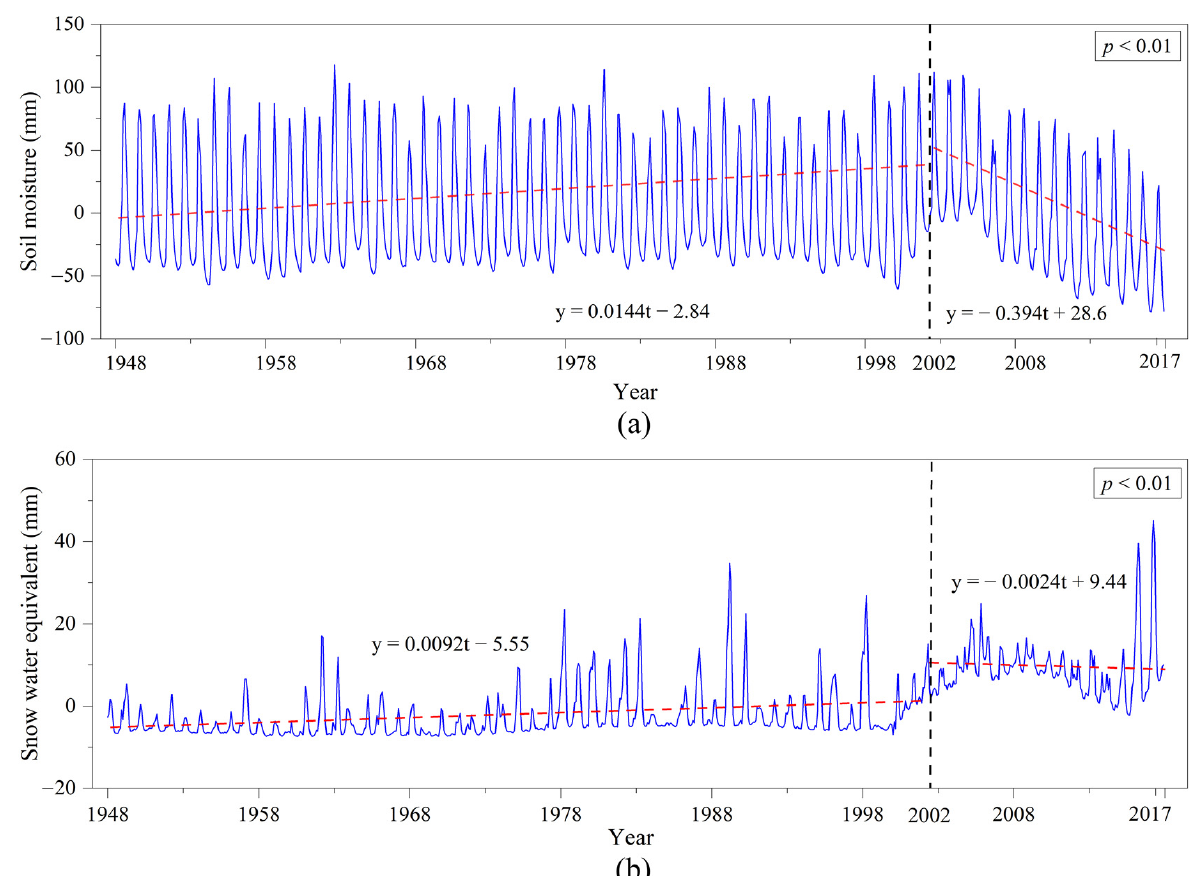
Figure 11. Monthly variation of soil moisture ( a ) and snow water equivalent ( b ) from 1948 to 2017. The vertical dashed line represents the dividing year of 2002.